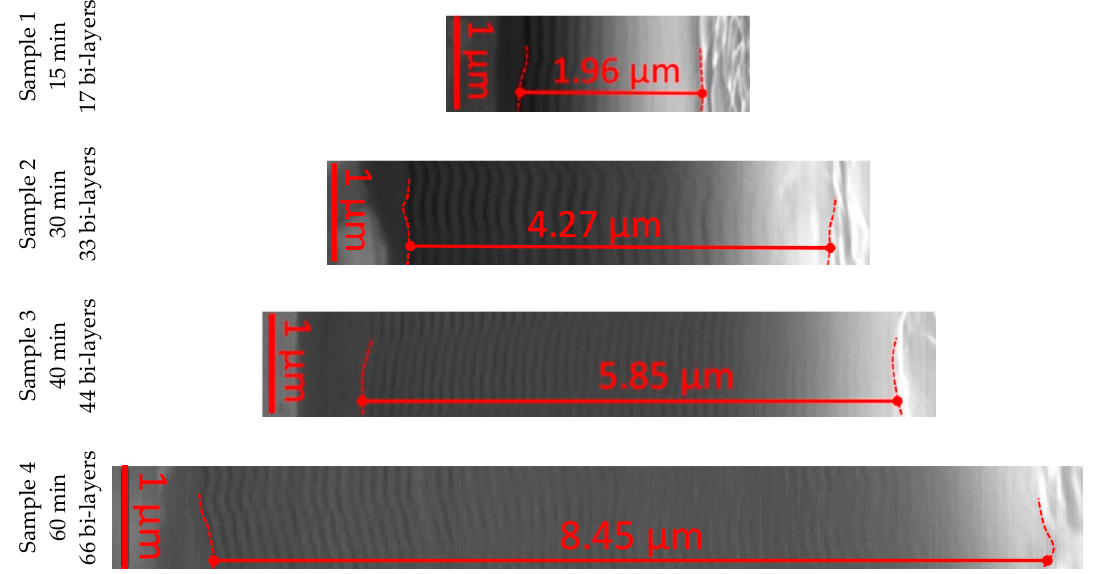
Figure 1. Cross sections on the Zr-ZrN-(Zr,Al,Si)N coatings under study.